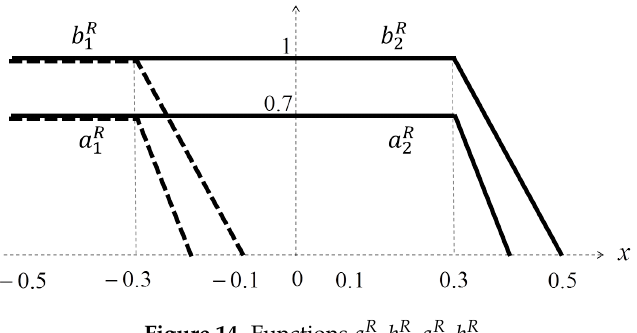
Figure 14. Functions a R